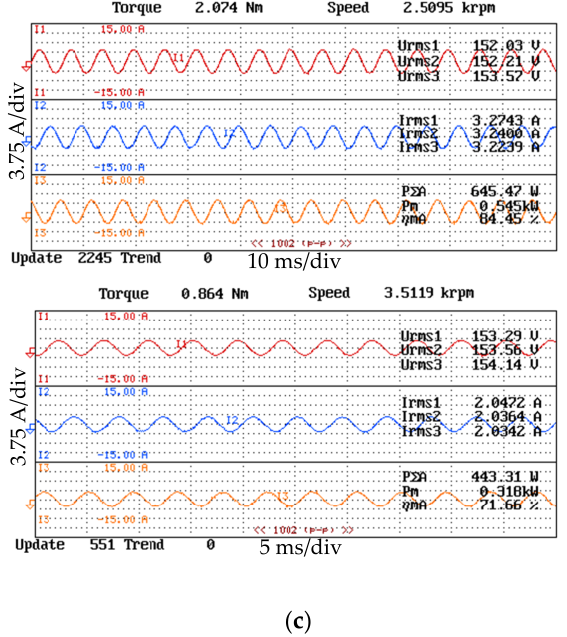
Figure 23. The working characteristics test: ( a ) the load experiment test system; ( b ) the torque and the efficiency of the PMSM based on the principle of variable exciting magnetic reluctance (VMRPMSM) and the traditional PMSM; ( c ) the measured current and torque operated at 500, 1500, 2500, 3500 r/min.